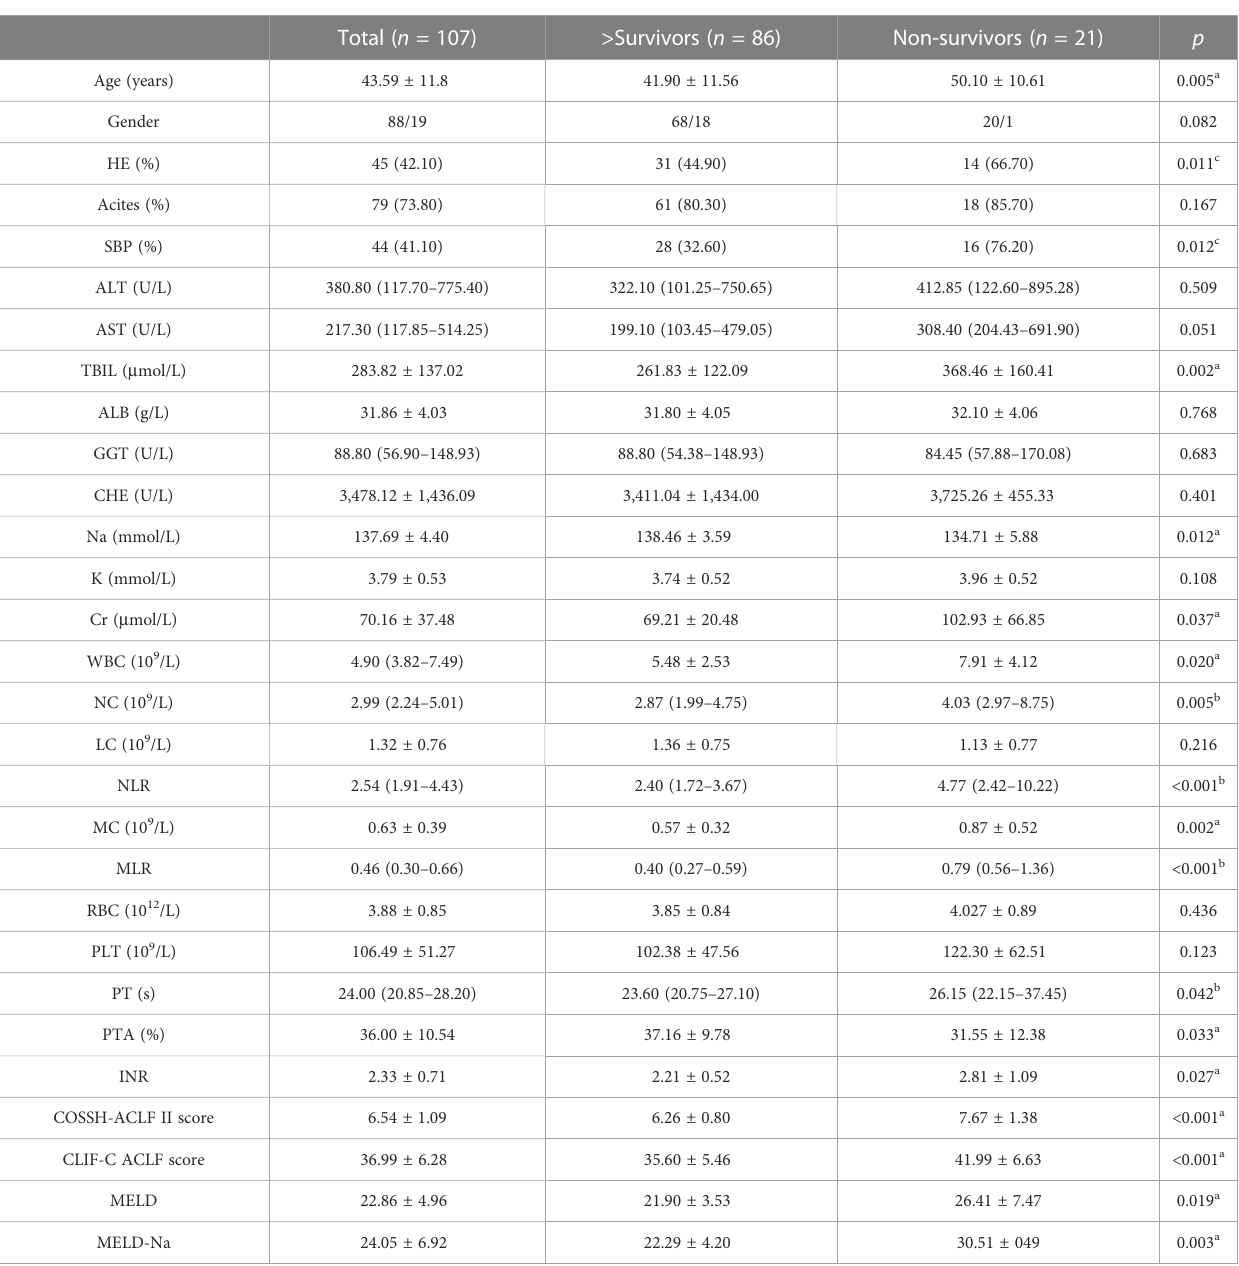
TABLE 1 Analysis of the clinical characteristics of the two